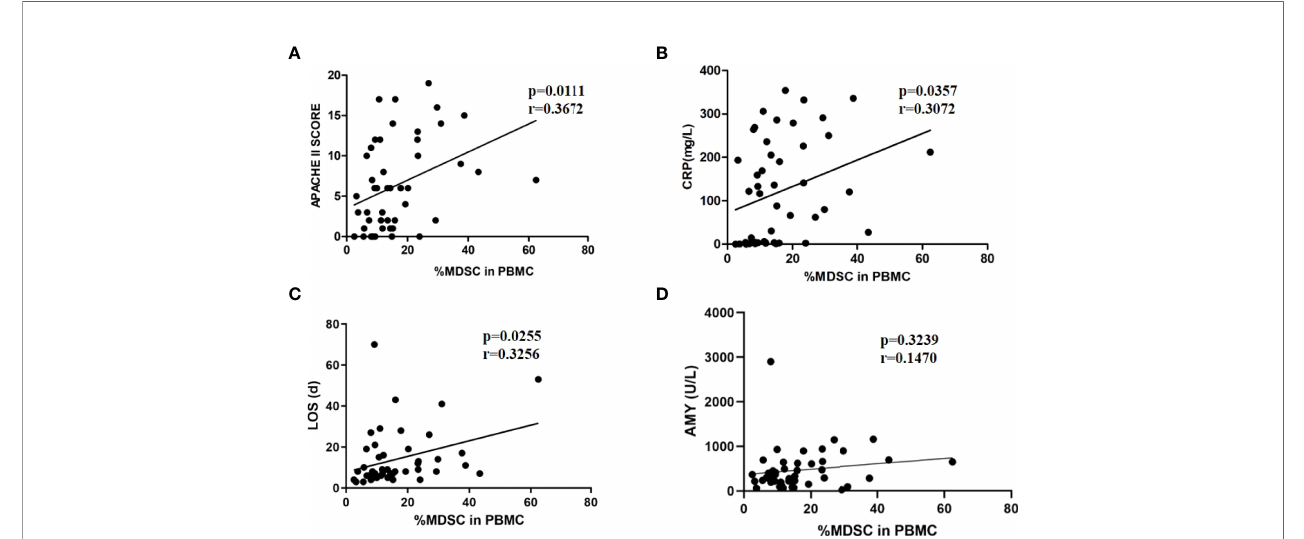
FIGURE 3 | The positive correlation between MDSC frequency and severity of AP. MDSC frequency was positively correlated to APACHE II scores (A) , CRP levels (B) , and LOS (C) . (D) MDSC frequency had no relationship with amylase